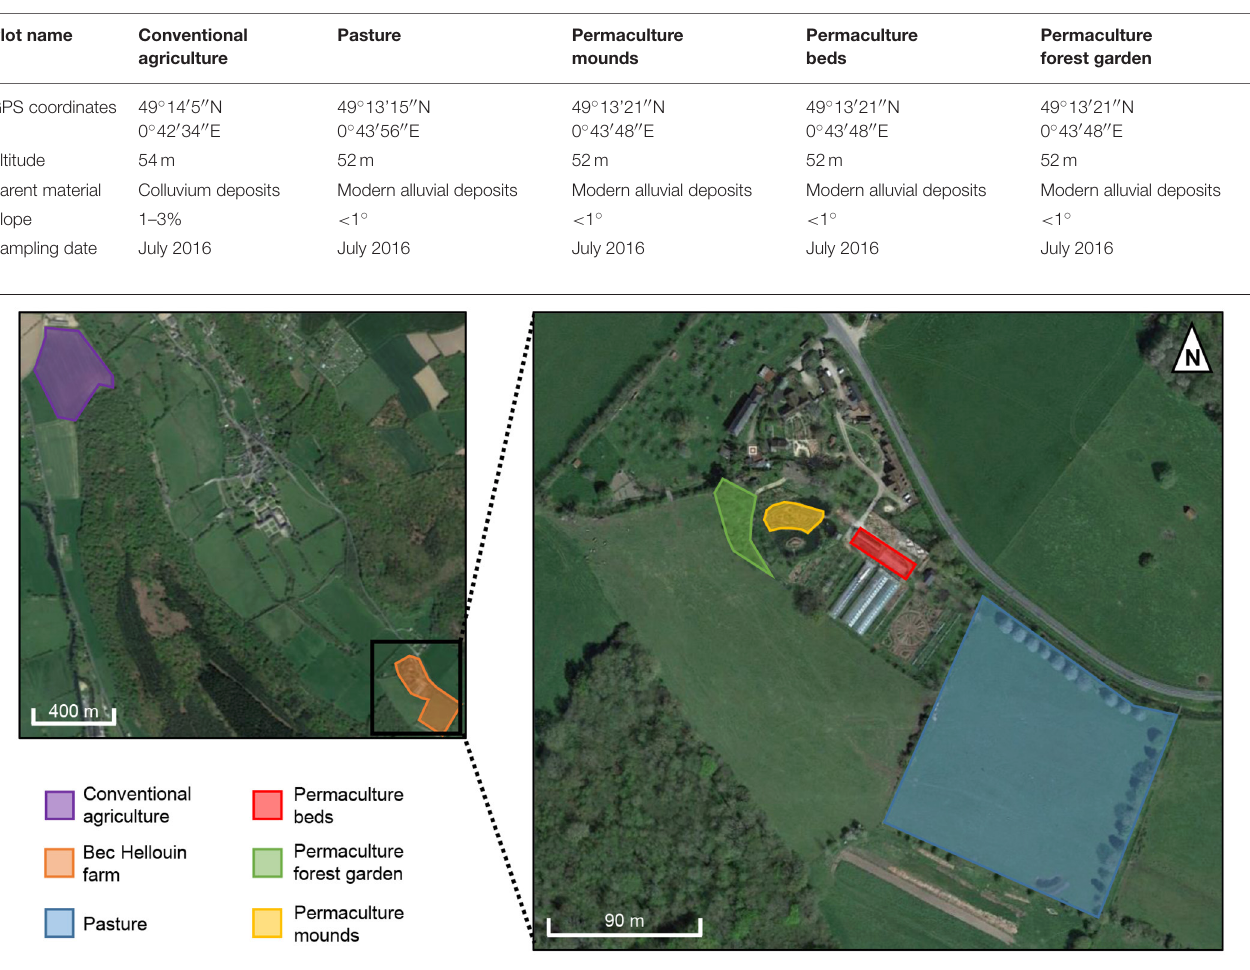
TABLE 1 | General description of the studied plots.